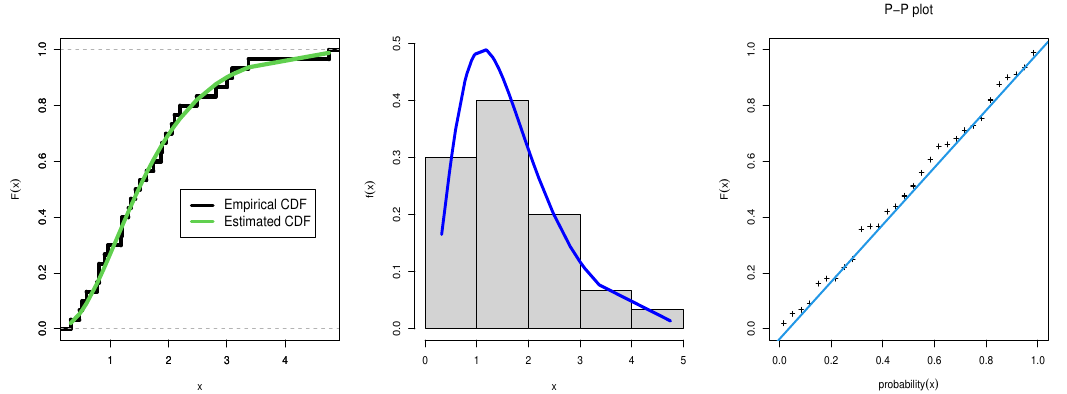
Figure 3. Estimated CDF, empirical CDF, estimated PDF with histogram, and P-P plot for the TTLLE distribution for data set 1.